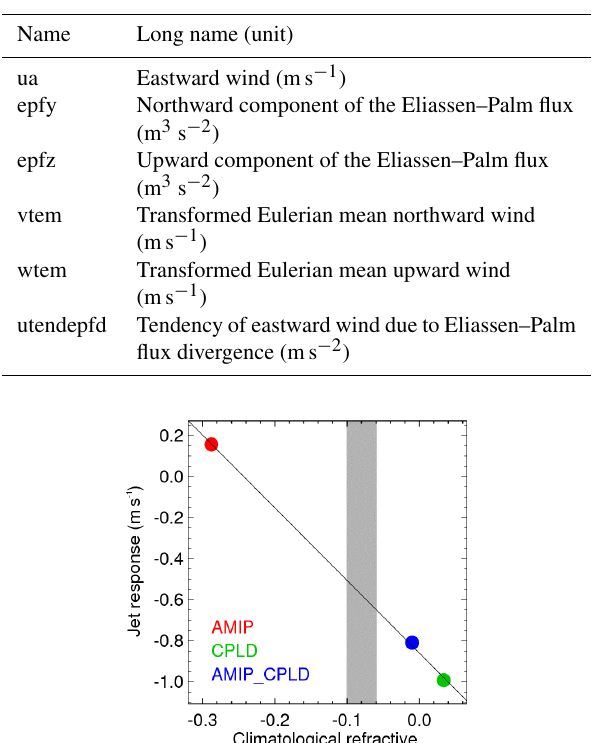
Table 3. Requested variables for diagnosing atmospheric zonal mo- mentum transport. Zonal mean variables (2-D, grid: YZT) on the plev39 grid (or a subset of plev39 for models which do contain all of the requested levels).